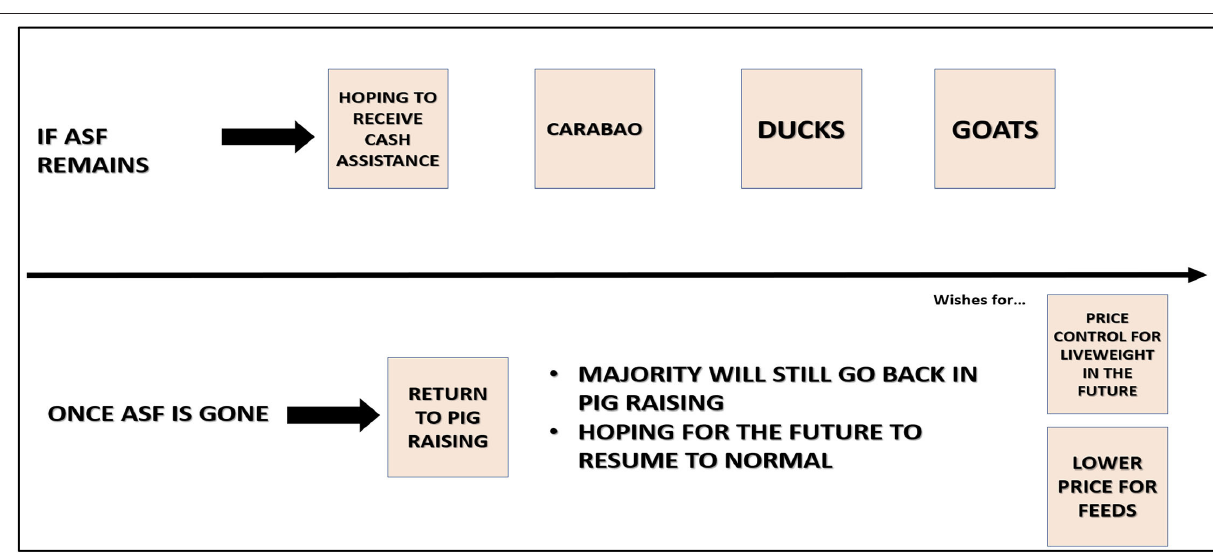
FIGURE 8 | Extension of community timeline into the future to stimulate focus group discussion on planned community responses to African Swine Fever